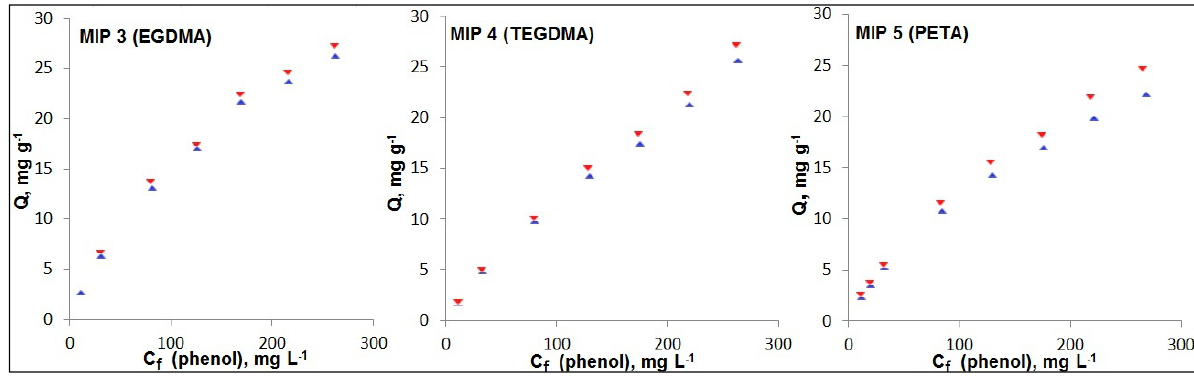
Figure 4. Binding isotherms for Sty-based MIP/NIP on different cross-linkers: EGDMA, TEGDMA, and PETA from 15 to 300 mg L − 1 phenol concentrations (initial); —MIP, —NIP. Note: C —phenol concentration at binding f